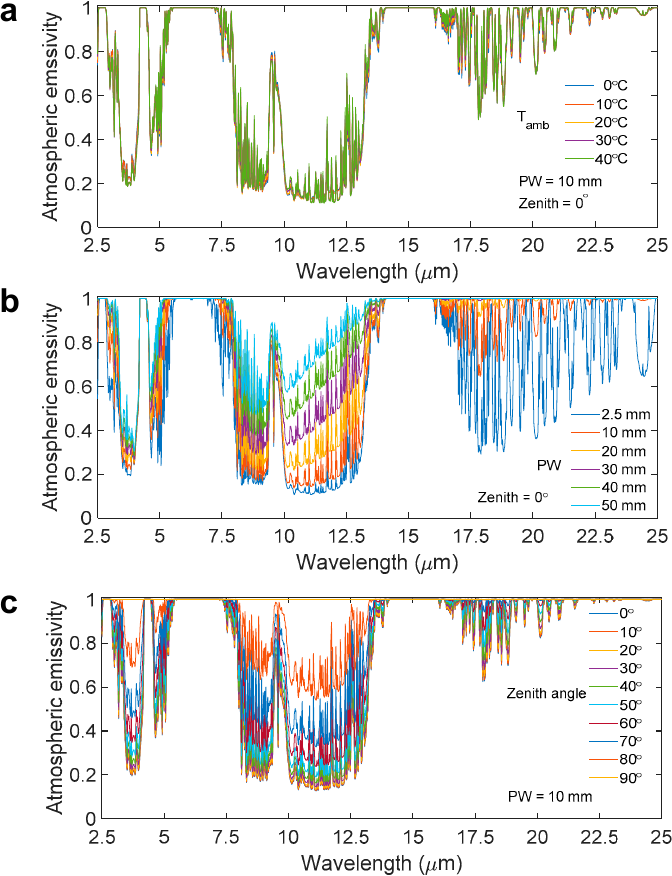
Figure 3. A set of effective spectral emissivity of a clear-sky mid-latitude summer atmosphere. ( a ) Effect of atmospheric temperature profile (represented by ambient temperature). ( b ) Effect of precipitable water. ( c ) Effect of zenith angle. The mid-latitude summer atmosphere model was used to compute the effective atmospheric spectral emissivity.